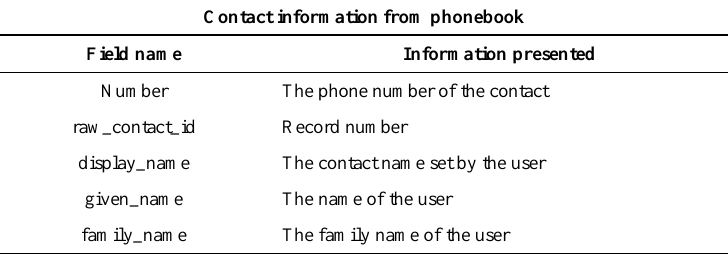
Table 7. Structure of the contacts wa.db - Information set by